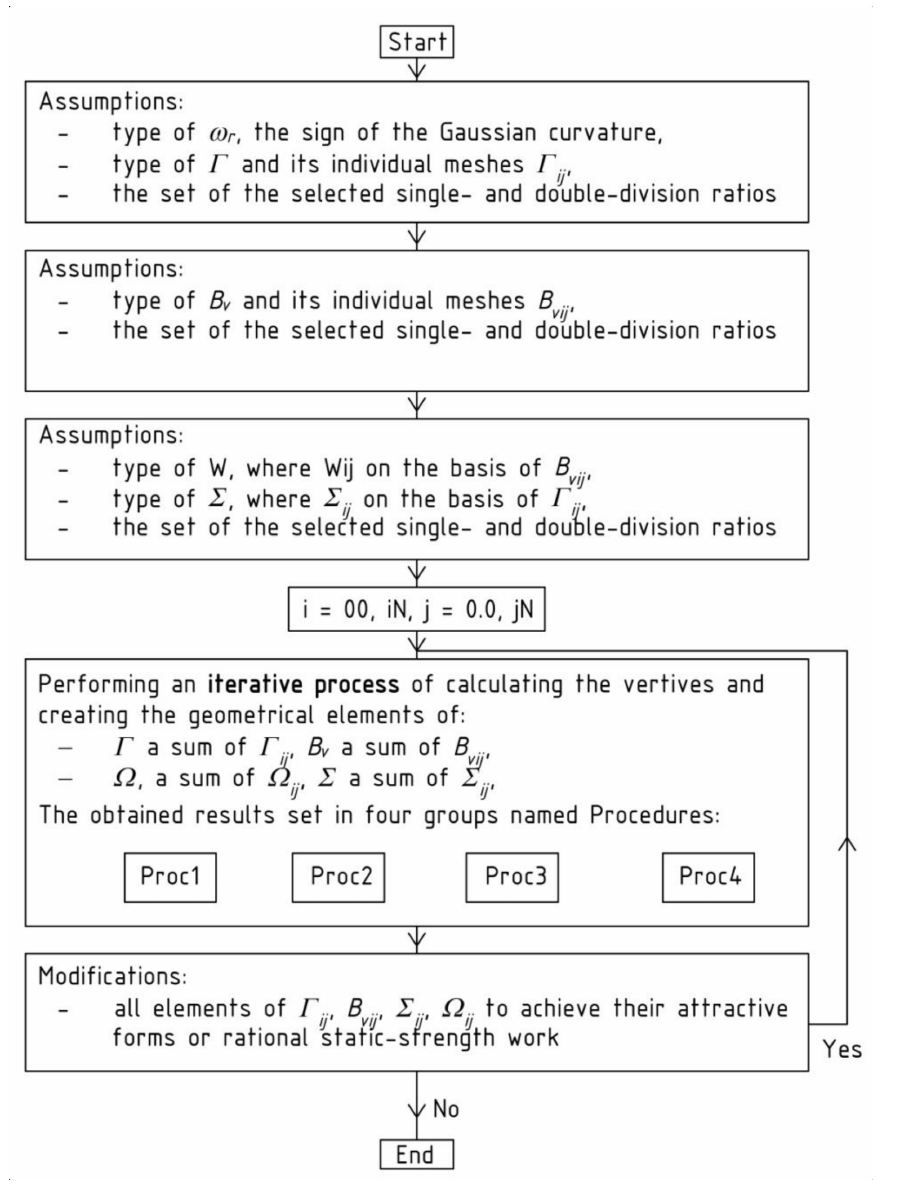
Figure 20. A block scheme of the method’s